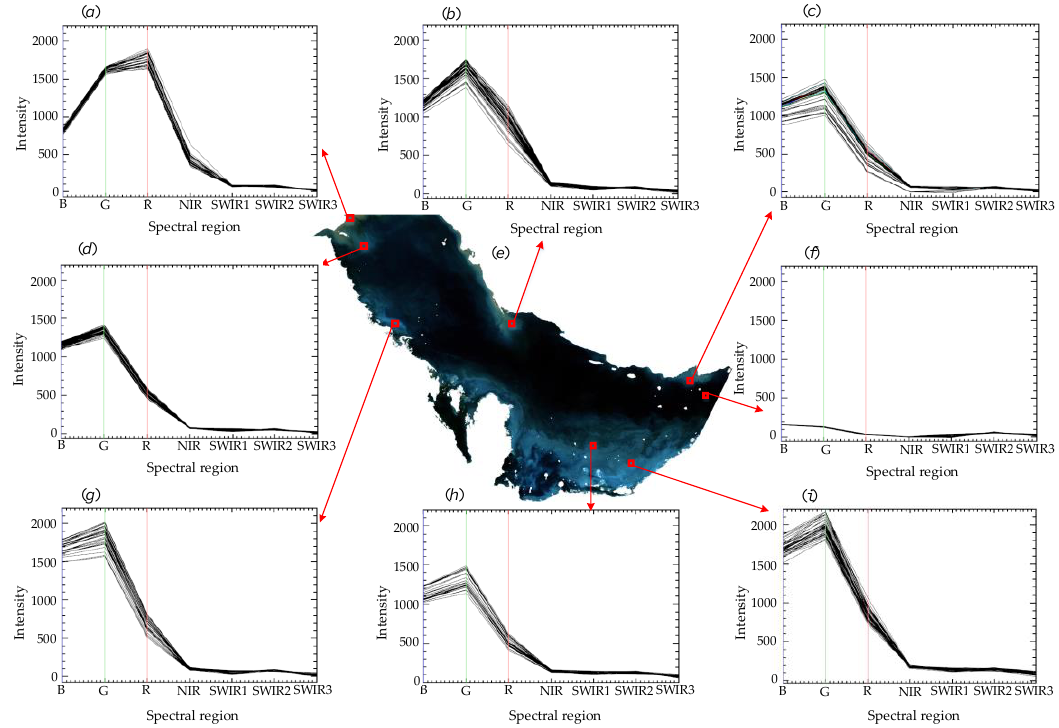
Figure 4. Spectral response of various surface features in a sample MODIS product (MOD09GA) for the Gulf.